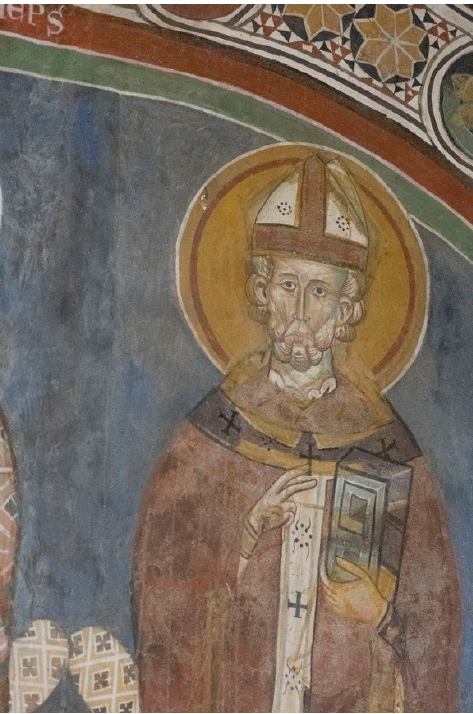
Figure 10. Sacro Speco, Subiaco (Italy), Lower Church. Fresco. Lunette, particular of St. Stephan. Photo: Davide Giannetti.